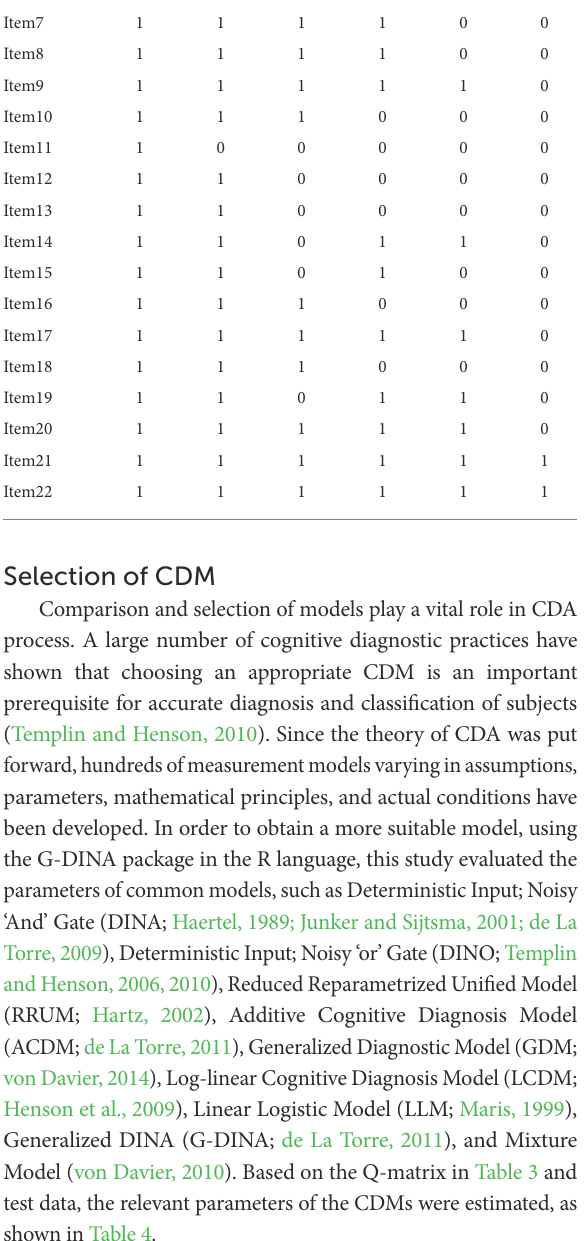
Table 3, we selected 60 items from one of the large-scaled Study (TIMSS) as the first round of items selected. Through coding the attributes of these items by the five experts, 22 items with high label consistency were finally selected as the assessment tools.